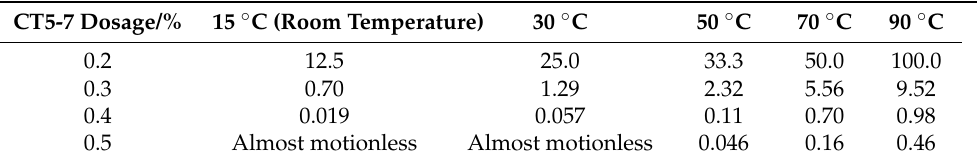
Table 4. Experimental results of gel fracturing fluid-suspended sand at different temperatures (mm/s). CT5-7